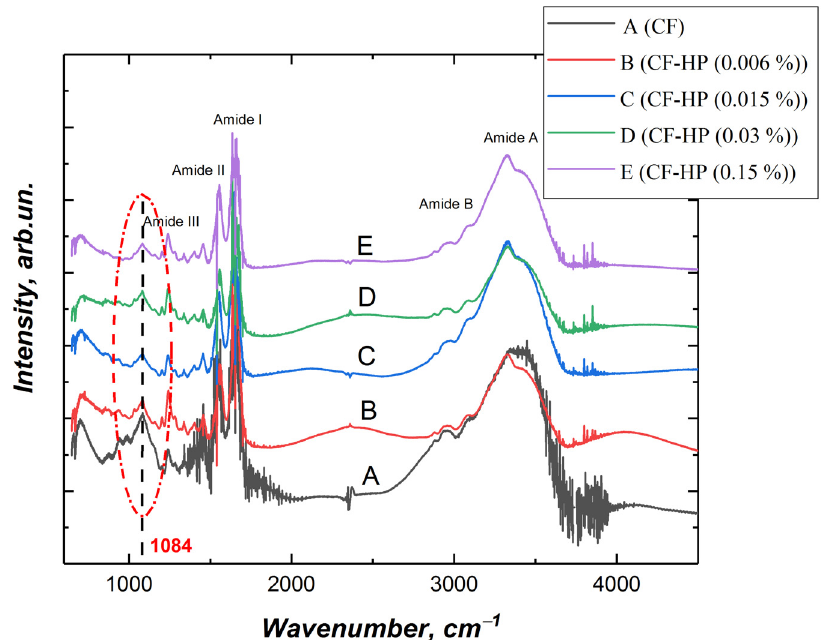
Figure 3. FTIR spectra of collagen fibrils after different HP treatment: CF—collagen fibrils before treatment; CF-HP (0.006%)—collagen fibrils after HP treatment with concentration 0.006%; CF-HP (0.015%)—collagen fibrils after HP treatment with concentration 0.015%; CF-HP (0.03%)—collagen fibrils after HP treatment with concentration 0.03%; CF-HP (0.15%)—collagen fibrils after HP treatment with concentration 0.15%.